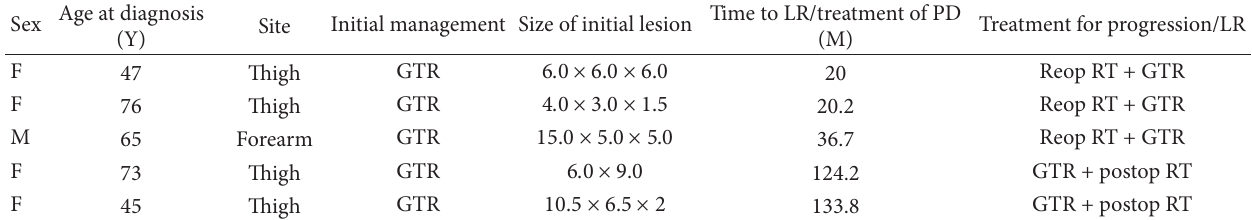
T 2: Treatment and follow-up summary.